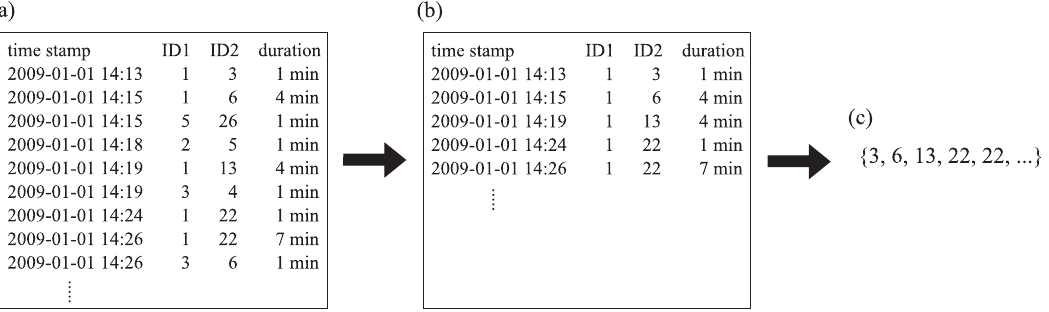
FIG. 1. Procedure for generating the partner sequence of individual 1. (a) Original data set. (b) List of conversation events that involve individual 1. (c) Partner sequence of individual 1. The data set shown in (a) is an artificial one, and is provided for the purpose of